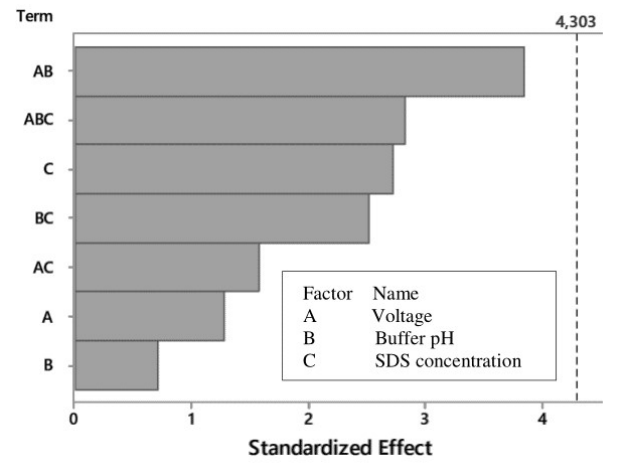
FIGURE 2 – Pareto plot of standardized effects (response is assay;